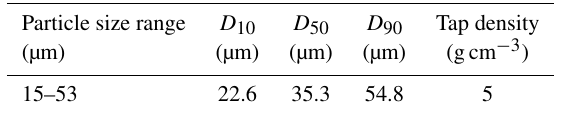
Figure 4. MR polishing device. Table 2. Particle size distribution and tap density of 316L stainless steel powder.